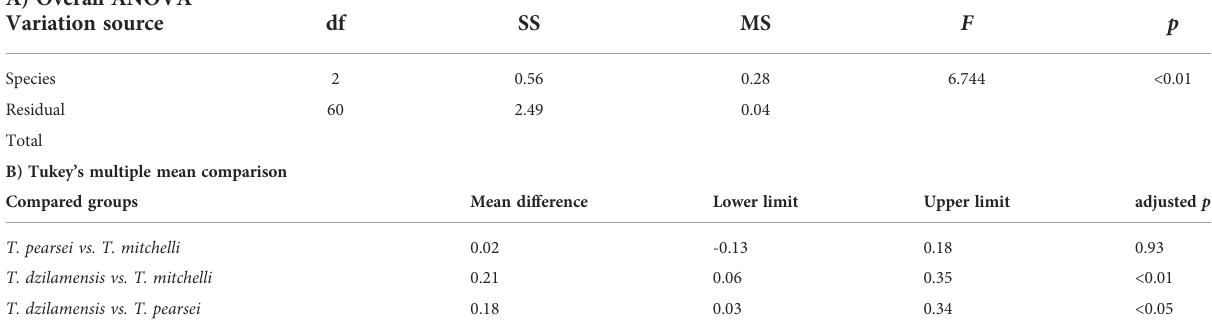
TABLE 4 Lactate accumulation before and after attainment of critical thermal limits in individuals of T. mitchelli , T. pearsei and T. dzilamensis